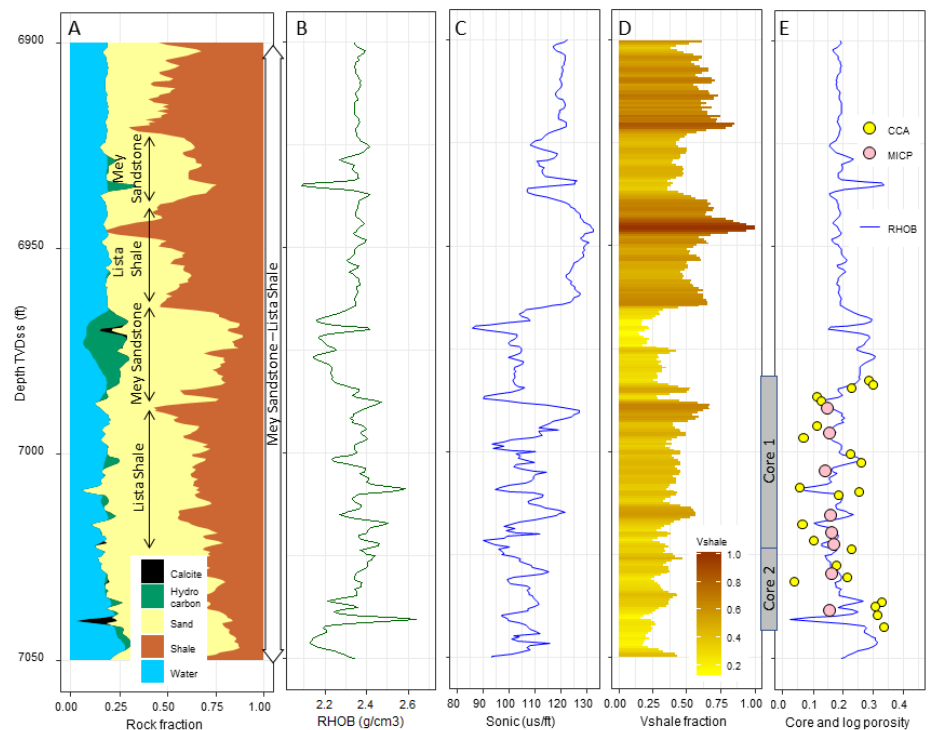
Figure 6. Wireline log raw and interpreted data from well 16/21a-13 from the Palaeocene East Mey Storage Site. ( A ) Interpreted lithology and fluid saturation diagram showing the Mey Sandstone and the interbedded Lista Shale baffle (i.e., intraformational shale). The most shaley part of the Lista was not cored in this well. ( B ) Density log; the neutron log was not run in this well, so a crossover diagram (e.g., Figure 3B) cannot be constructed. ( C ) Sonic log data; only the compressional